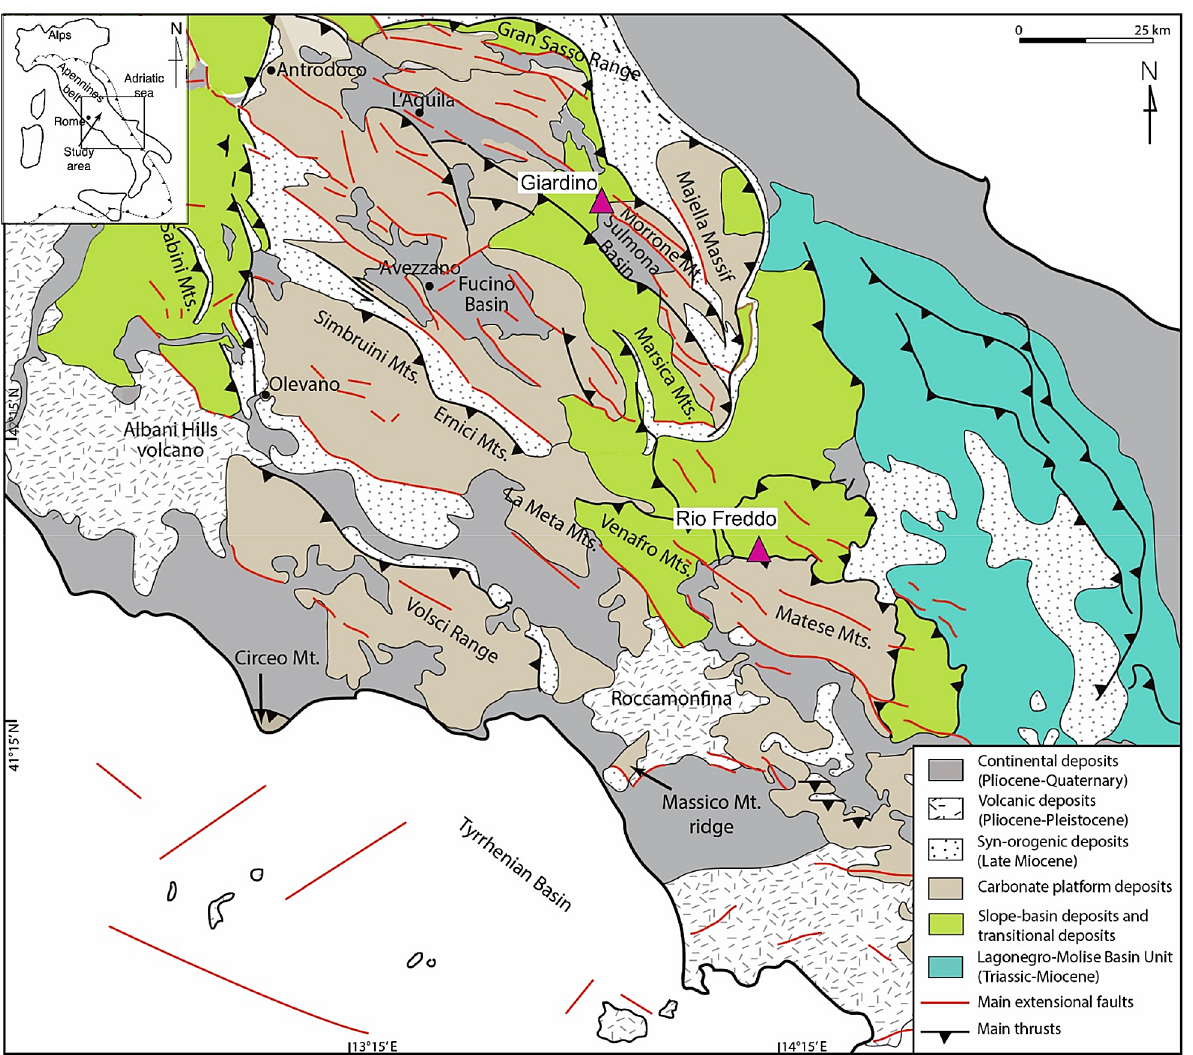
Fig. 1 Regional geological map of central-southern Apennines, Italy. Modified from